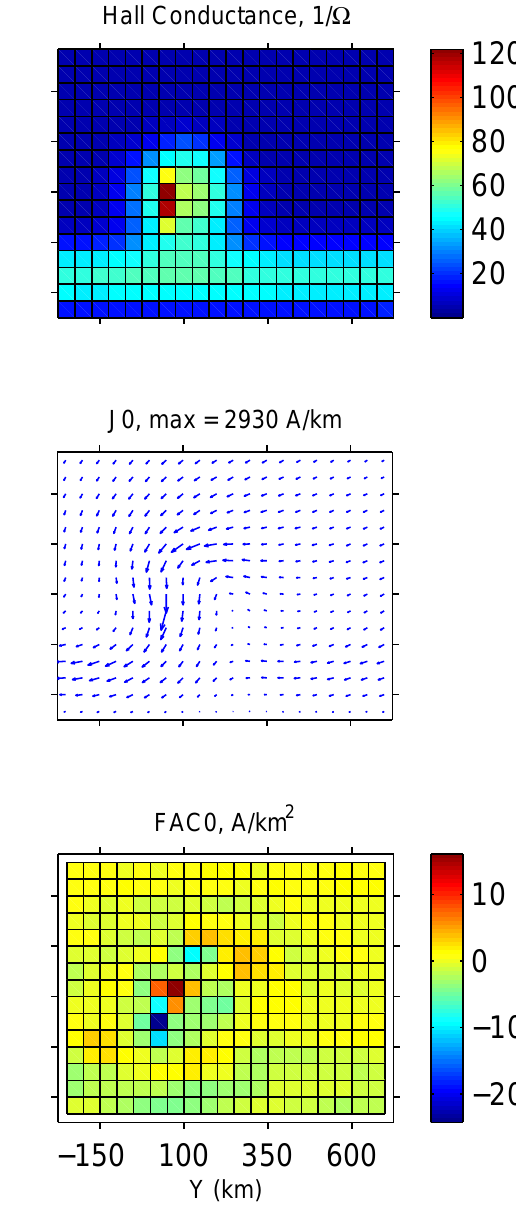
Fig. 5. The (cid:127) -band model. Pedersen and Hall Conductances, electric field E 0 , ionospheric current density J 0 , divergence of the electric field and FAC. Note the different scales of the vector